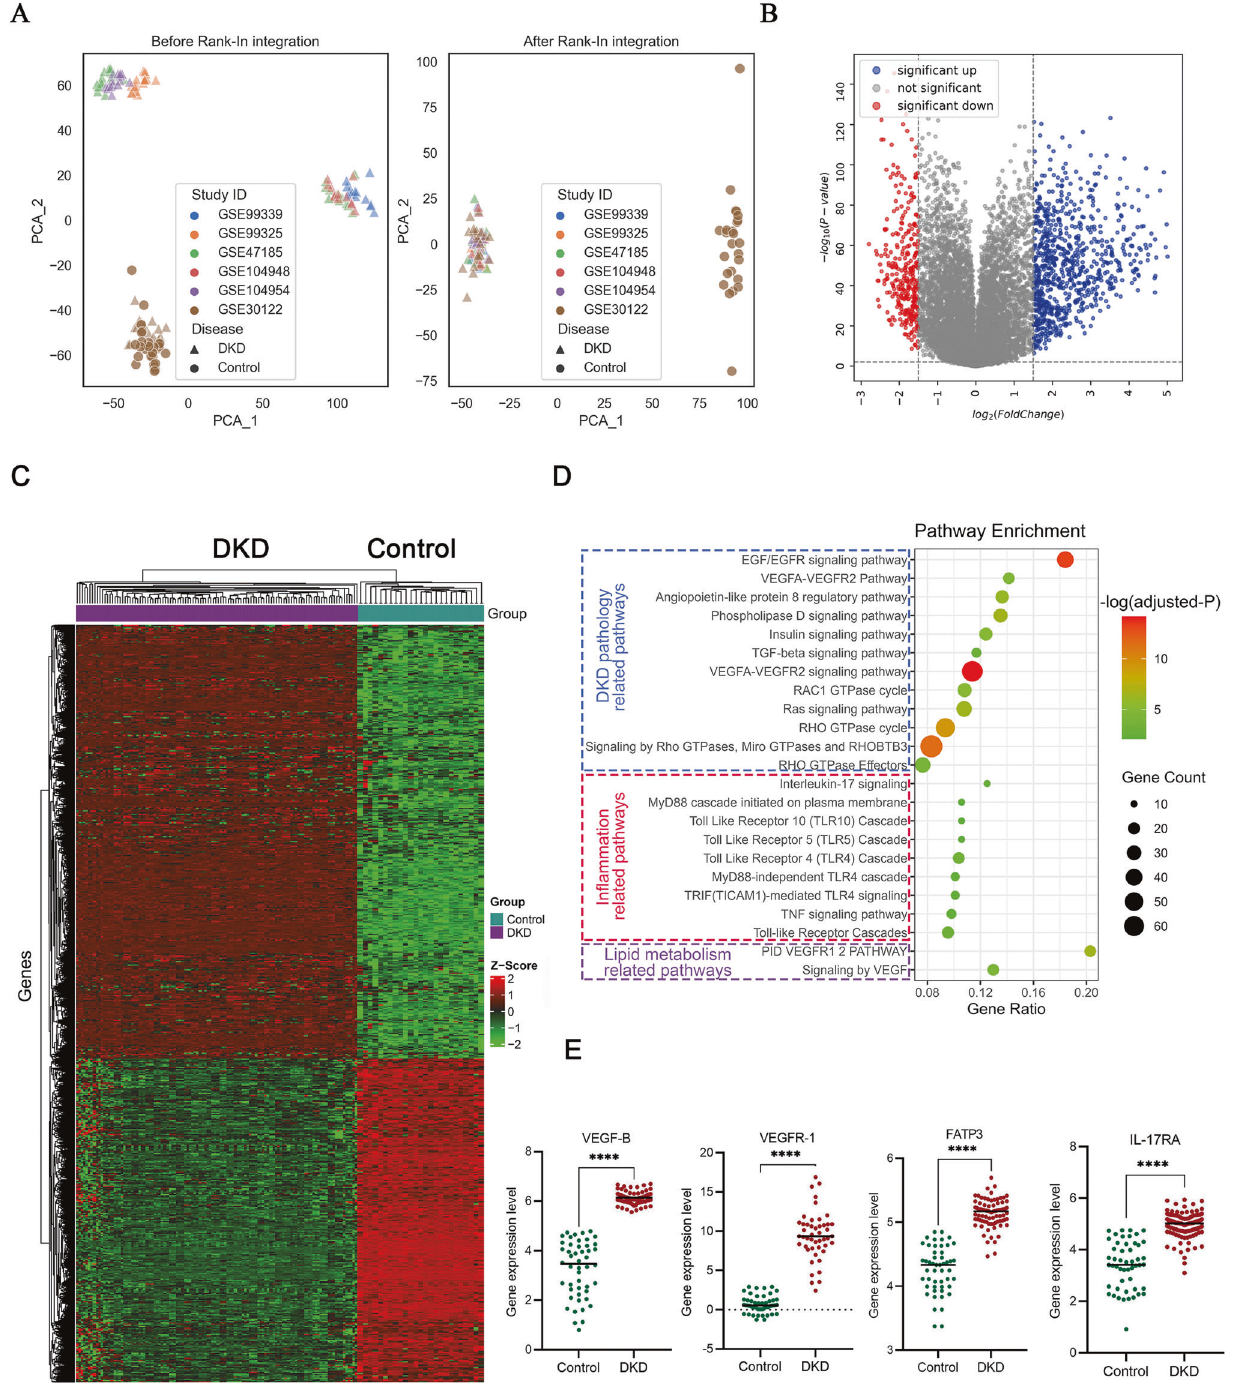
Fig. 1 Bioinformatics analysis of publicly available gene expression dataset of DKD patients. A Distribution of samples of control and DKD patients before and after Rank-In integration. The source study IDs (in GSExxx format) were indicated by different colors. B Differential expressed genes (DEGs) analysis using the limma algorithm. log2 (fold change) of 1.5 and log10 (FDR-adjusted P values) of 0.01 were indicated with dash lines in the plot. C DEGs were represented in the heatmap by hierarchical clustering of both genes and samples according to their gene expression Z -scores. D Signi fi cantly enriched signaling pathways in three categories were visualized in the bubble chart. E Gene expression values of VEGF-B, VEGFR-1, FATP3 and IL-17RA between control and DKD samples were compared with Student ’ s t -test, n = 50-112. **** P <